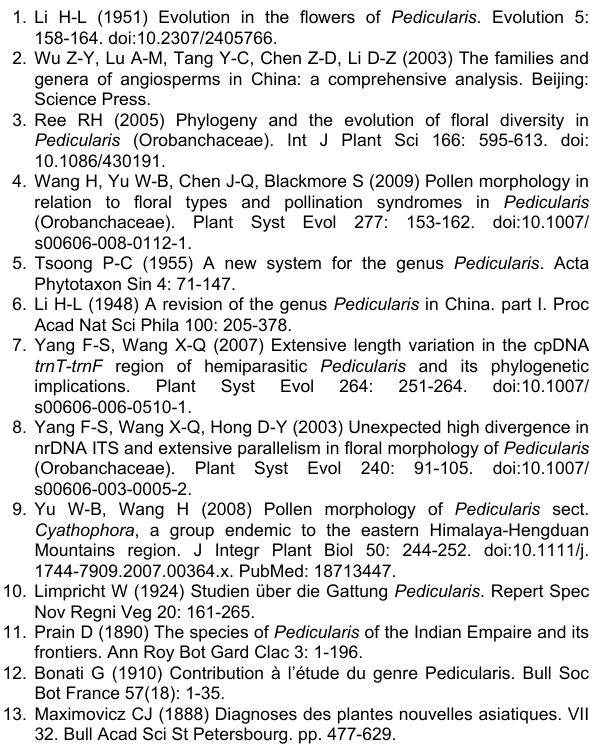
Table S1. Summary information of included samples in this